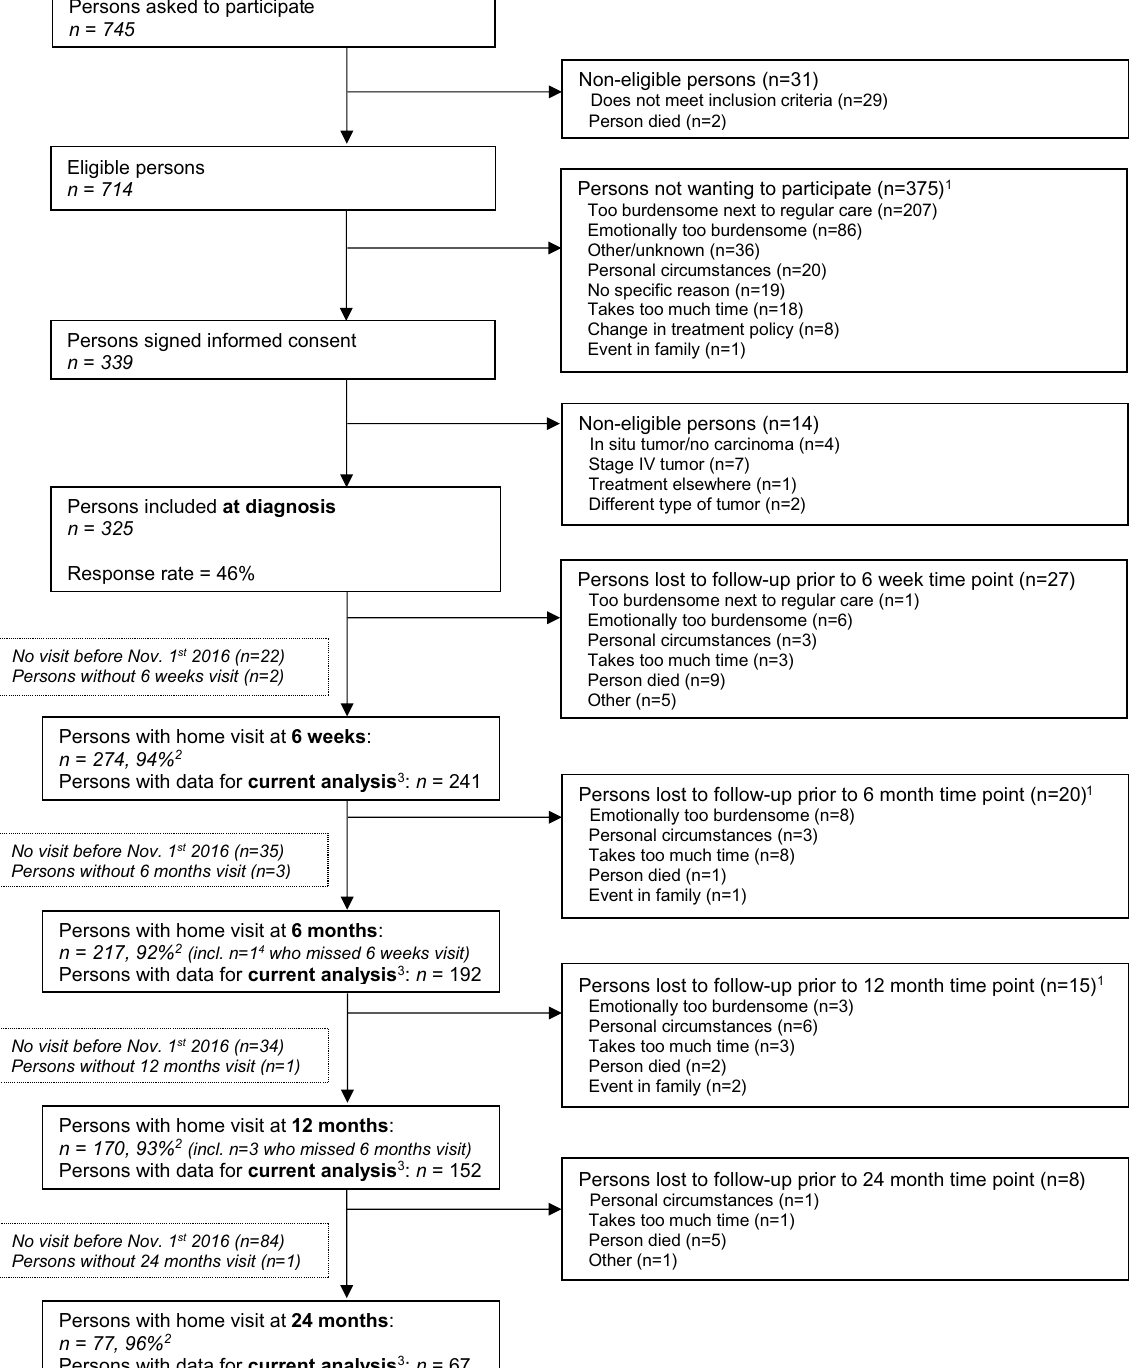
Figure 1. Flow diagram of participants and measurements within the EnCoRe study and the number of post- treatment measurements included in the analyses presented in this paper. Data collected up until November 1st 2016 were included in the analyses. 1 Totals do not add up because some individuals reported multiple reasons for non-participation. 2 Response rate = (persons with home visits)/(persons with home visits + persons lost to follow-up – persons died). The declining numbers of participants at subsequent time points are predominantly due to the fact that not all participants had reached yet these time points on November 1st 2016. 3 Since the current analysis was focused on physical activity and metabolites after colorectal cancer treatment, only post-treatment measurements with available data on self-reported physical activity, metabolites and covariates were included. A total of n = 252 participants with at least one post-treatment measurement including these data were included in the analysis. The number of participants with available physical activity and metabolites data were respectively n = 268 and n = 249 at 6 weeks, n = 215 and n = 203 at 6 months, n = 169 and n = 162 at 1 year, and n = 72 and n = 73 at 2 years post-treatment. 4 Other person who also missed 6 weeks visit did not have follow-up visit before November 1st